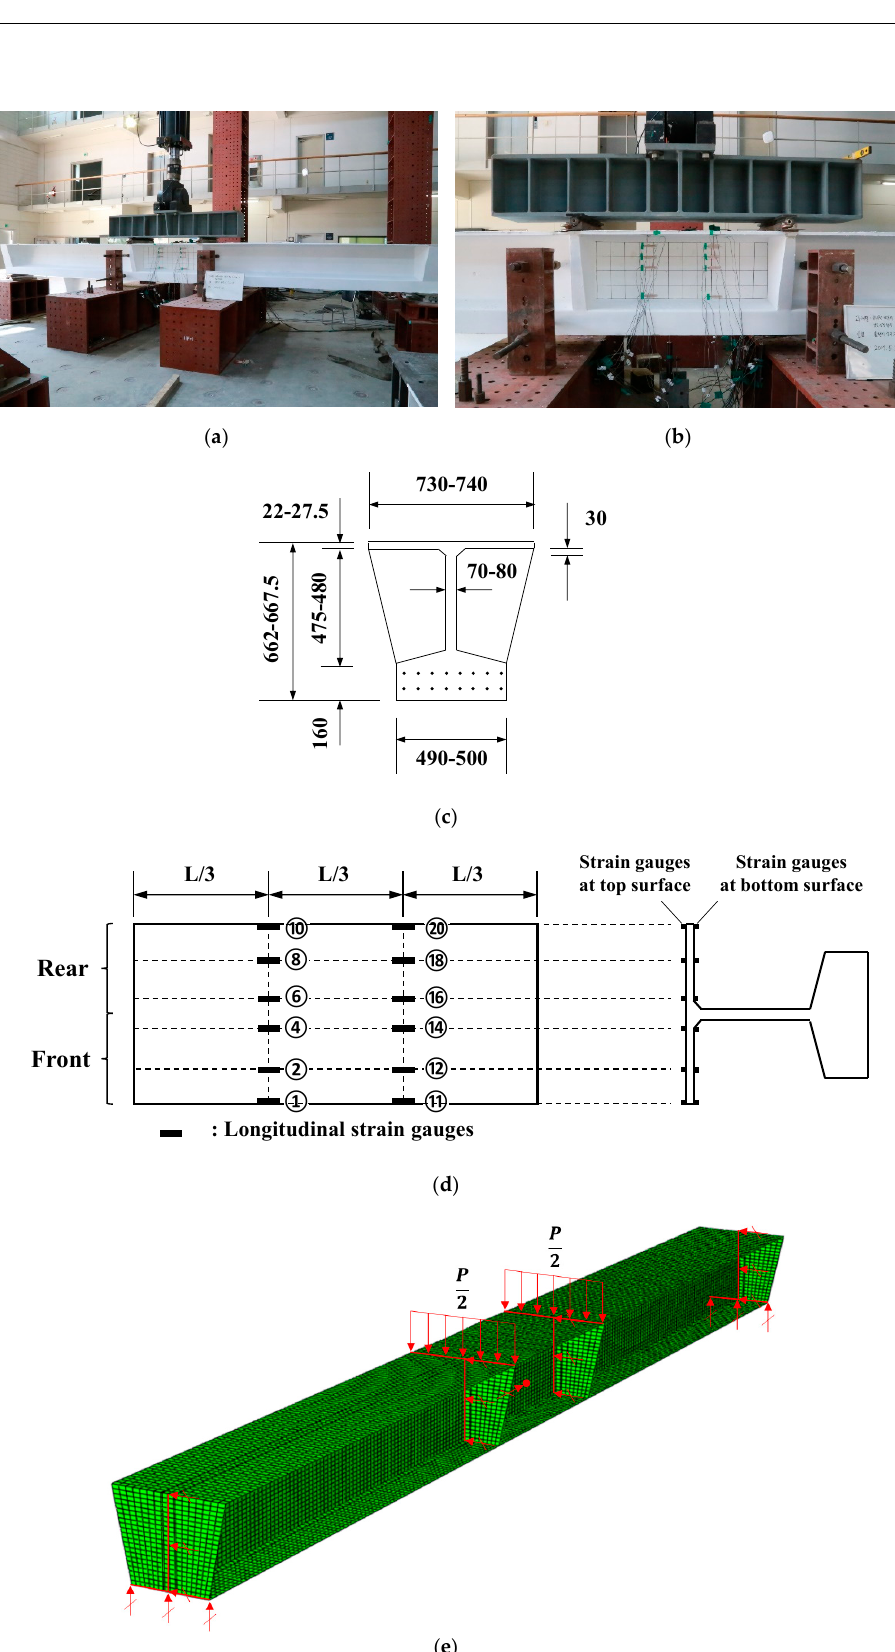
Figure 16. Test specimens and test set-up in literature. ( a ) Illustration of test setup, ( b ) test zone of the specimens, ( c ) dimensions of cross-section of flanges at test zone, ( d ) longitudinal strain gauge locations of flanges in the test zone, and ( e ) an example of the established three-dimensional FEA model (test specimens conducted from reference